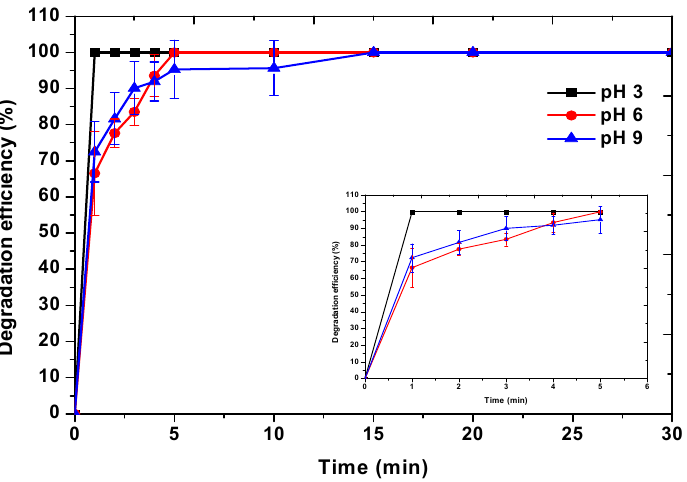
Figure 6. Degradation efficiencies of methyl orange dye (10 mg/L) using 10 mg Fe/Cu/Ag 5:1:0.2 nanoparticles with different pH conditions at room